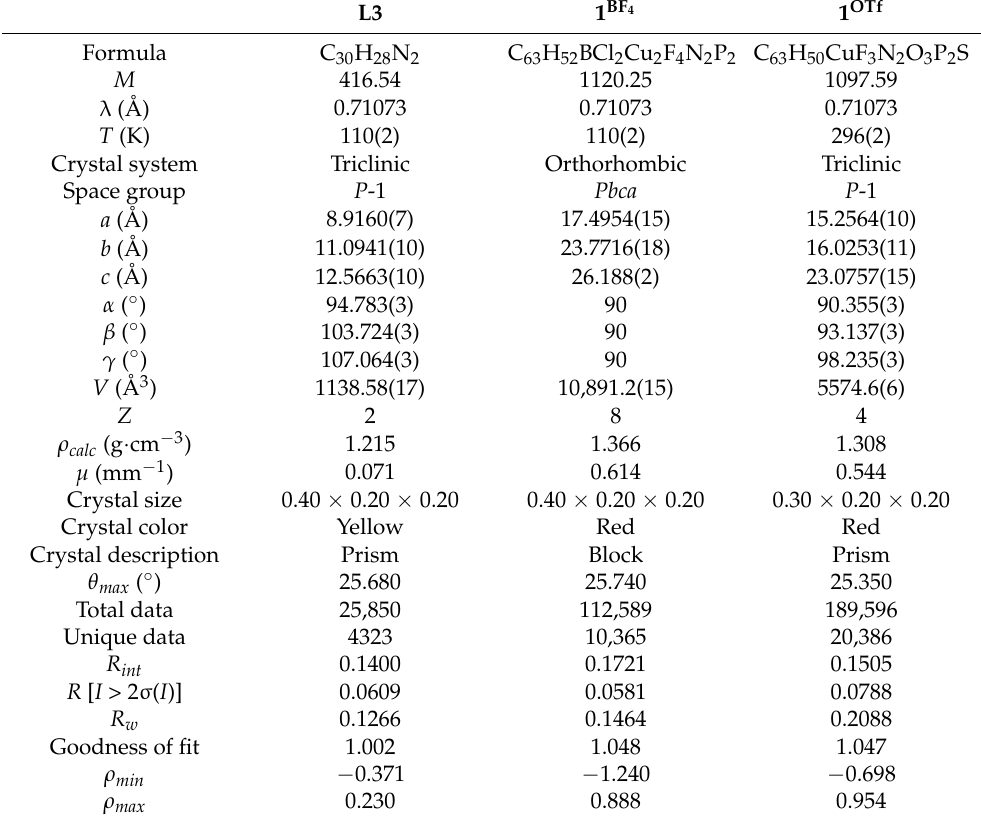
Table 3. Crystallographic data and details about refinement for structures L3, 1 BF 4 and 1 OTf